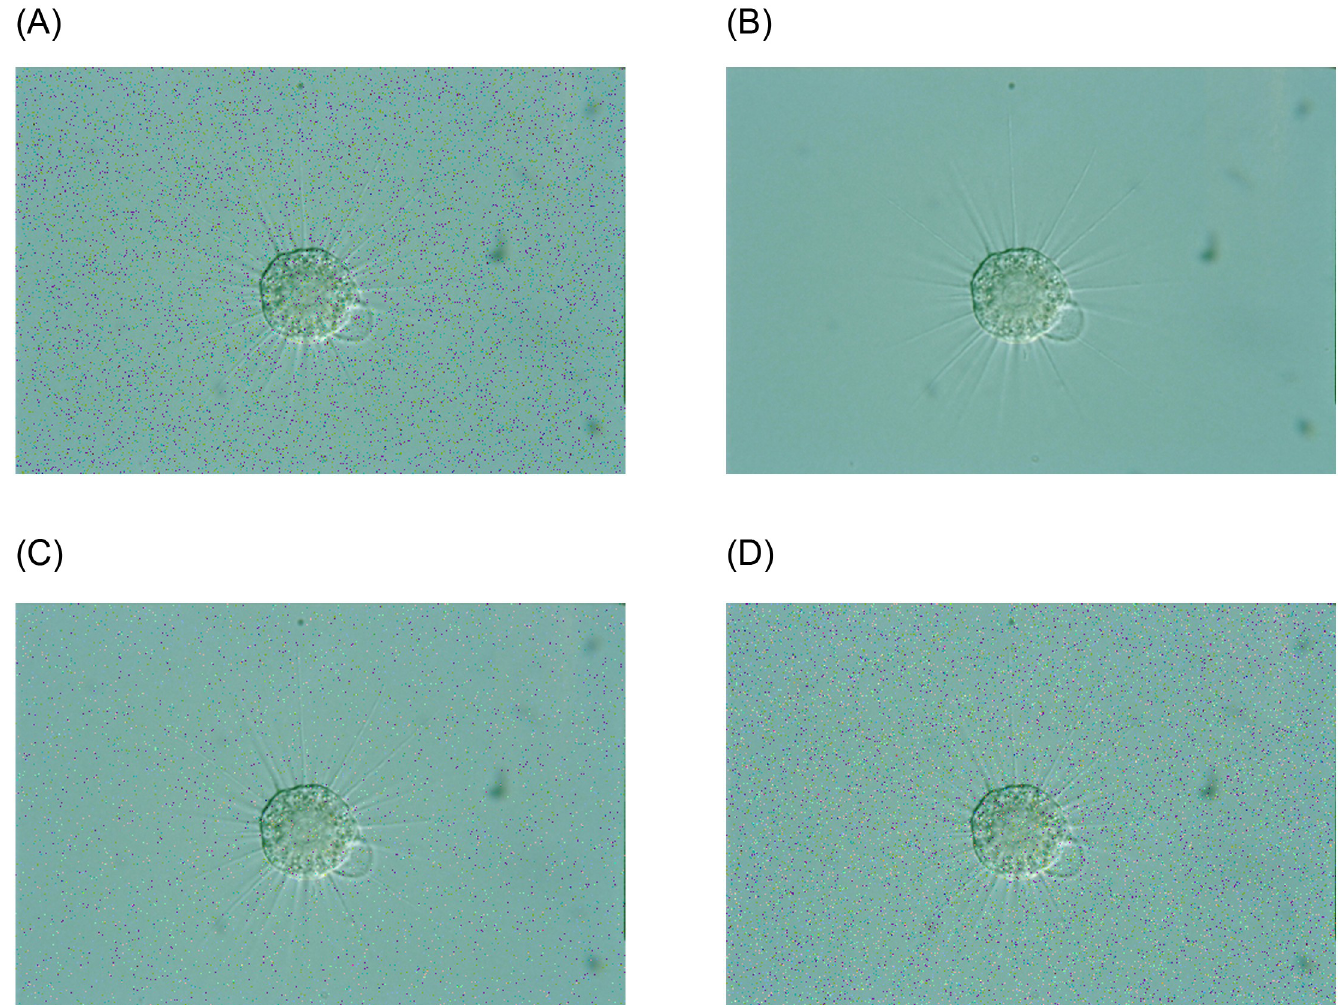
Fig 3. An example of different noisy EM images using EMDS-5